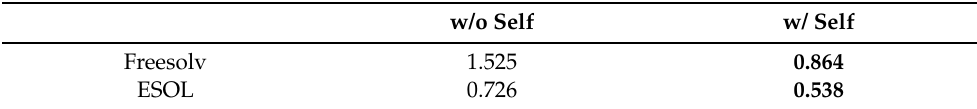
Table 9. Aberage of MAE with and without self node features.